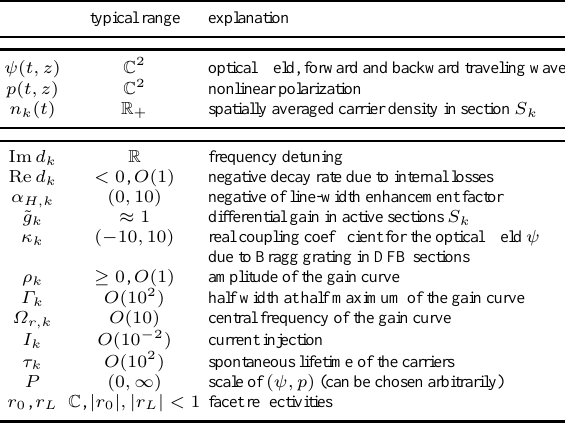
Table 1. Ranges and explanations of the variables and coefficients appearing in (2.1) – (2.4). See also [3] to inspect their relations to the originally used physical quantities and